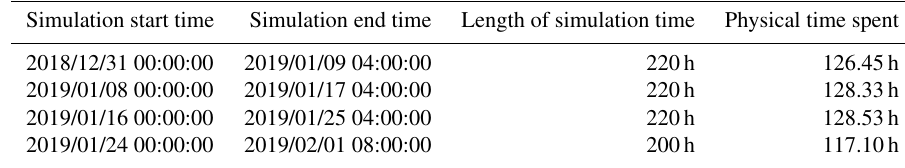
Table A1. The division of each simulation time period and the physical time spent on the simulation.